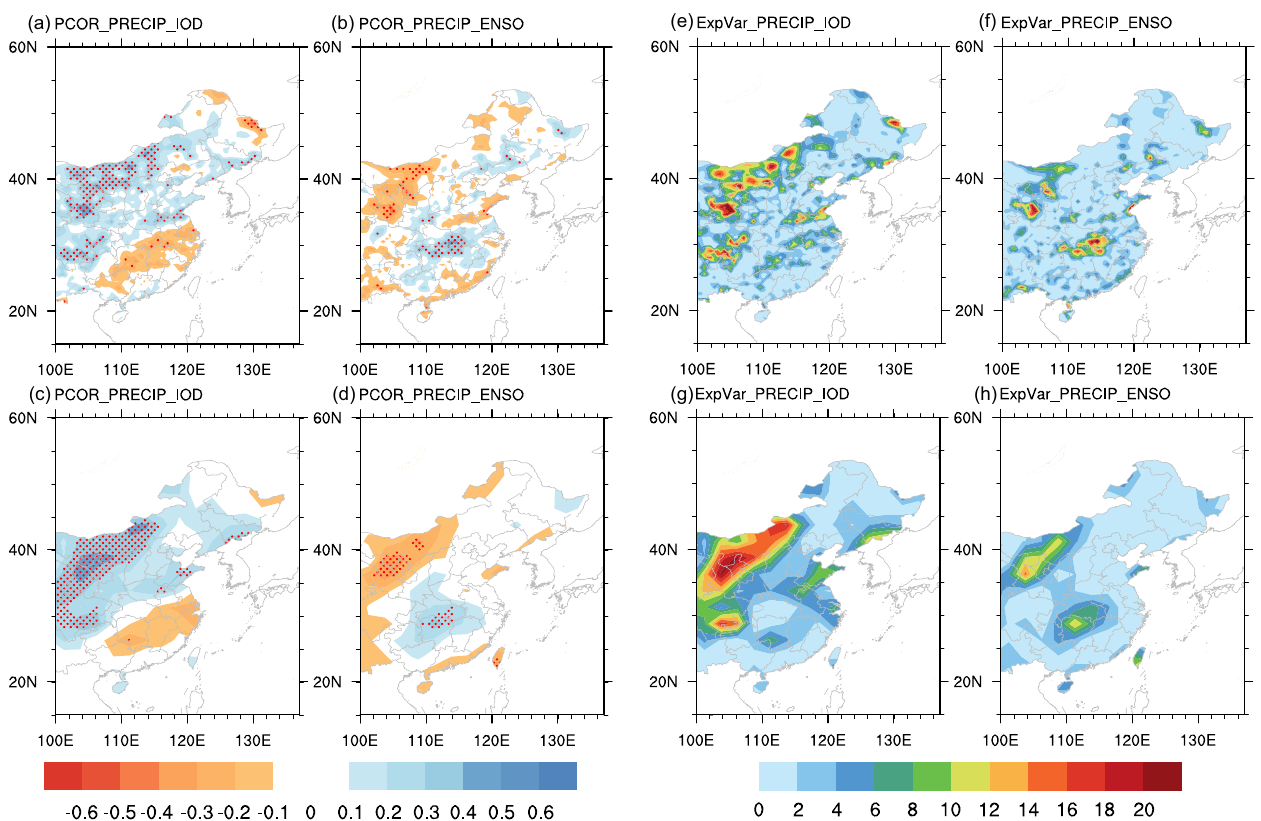
Fig. 1 Precipitation patterns associated with the preceding IOD and ENSO. Partial correlations of precipitation during the ensuing summer with the DMI of the preceding autumn after removing the linear relationship with Niño 3.4 of winter based on a station precipitation data, and b GPCP data during 1979 – 2021. c and d as in a and b , but with Niño 3.4 of winter after deducing the linear relationship with the DMI of the preceding autumn. Variance fraction of summer precipitation (%) accounted for by e and f the DMI in autumn and g , h Niño 3.4 in winter based on e , g station data, and f , h GPCP data. Dotted areas in a – d represent statistical signi fi cance at the 95% con fi dence